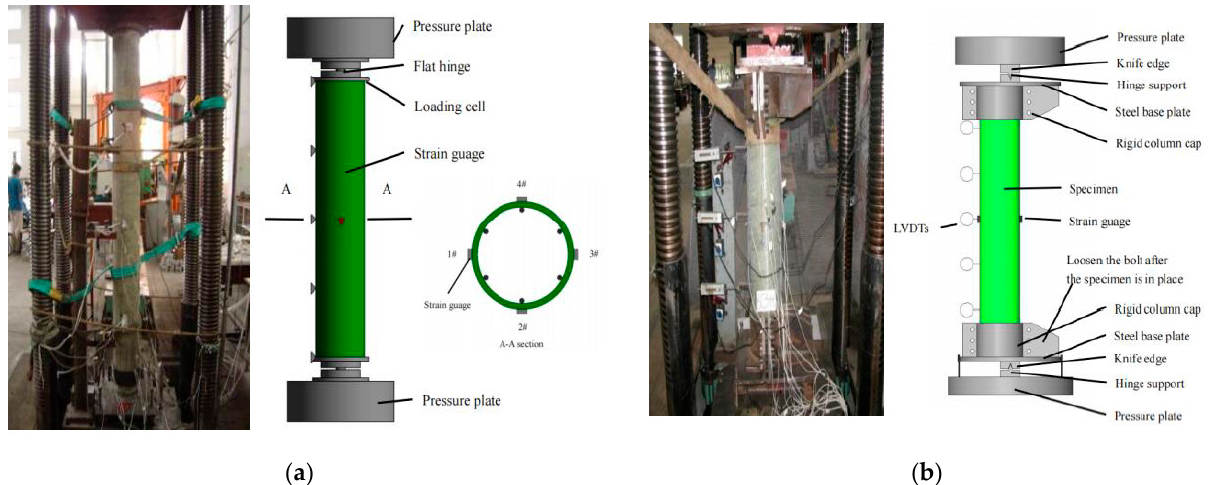
Figure 1. Test setup and instrumentation: ( a ) A composite slender column under an axial load; ( b ) A CFGT composite column under an eccentric load.